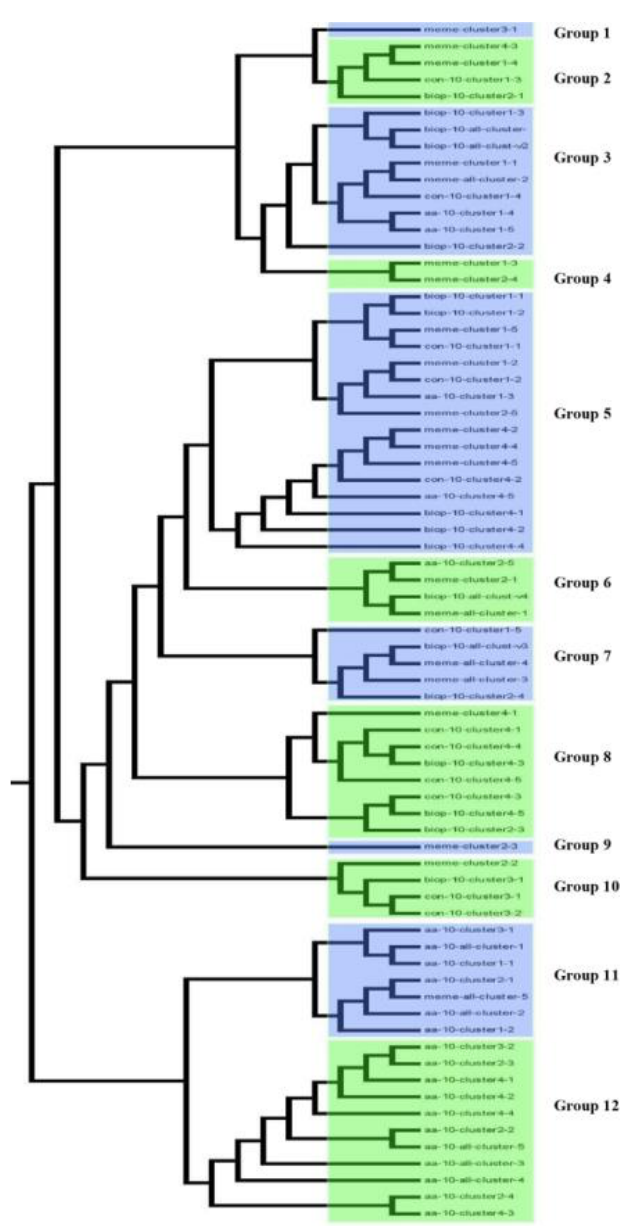
Figure 2. Classification of motifs using MEGA. All 73 motifs clustered into 12 groups.